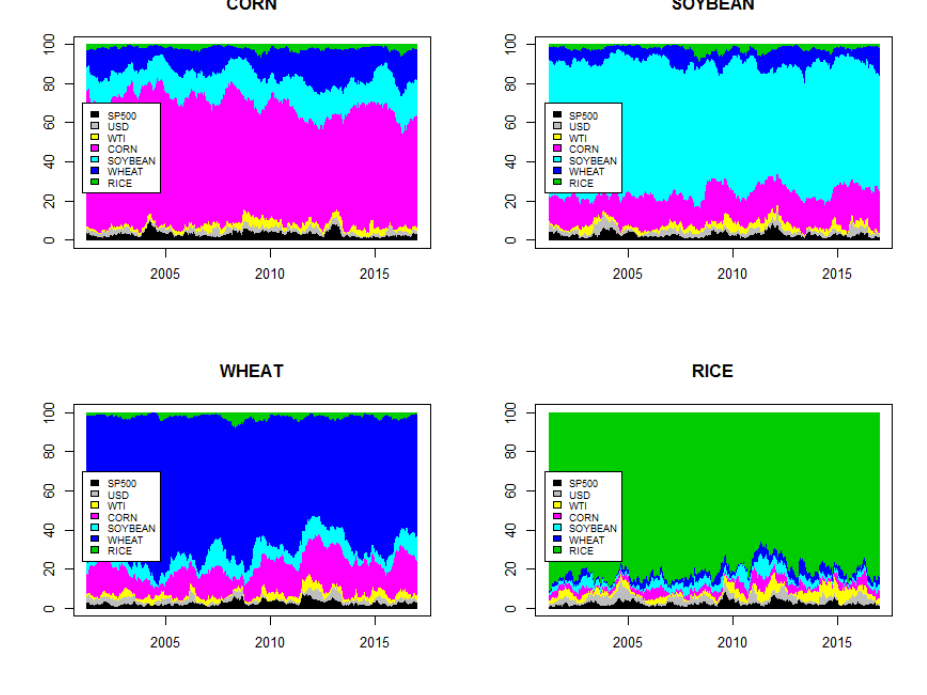
Figure 7A: The forecast error variance decompositions (FEVD) of the food markets (the OLS